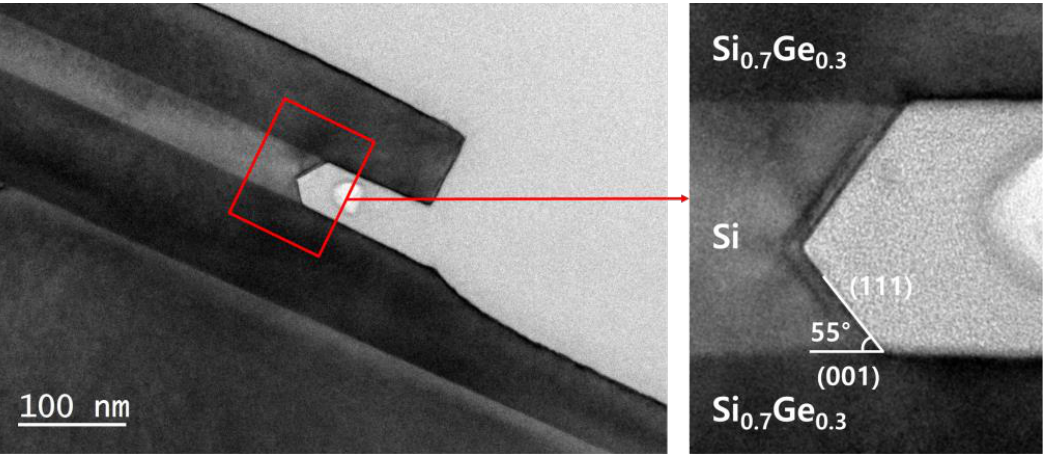
Figure 9. Cross-sectional transmission electron microscopy image of Si 0.7 Ge 0.3 /Si/Si 0.7 Ge 0.3 multi-layer after selective etching of Si in TMAH.